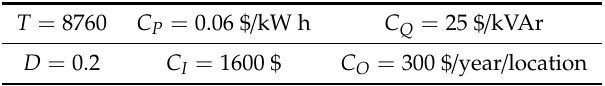
Table 1. The utilized parameters of the total cost objective